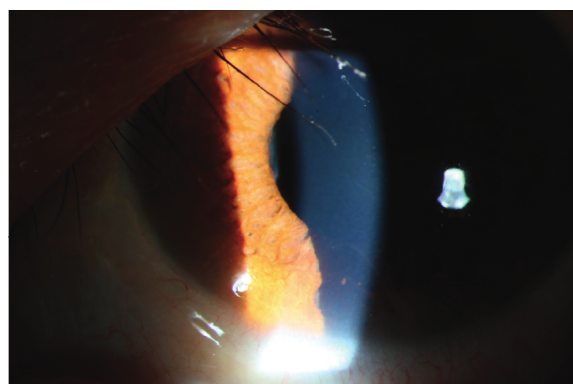
Figure 3: Pigmented KP under a slit lamp. Color photograph of the left eye of a 46-year-old female patient shows typical pigmented KP and moth-eaten iris depigmentation under a slit lamp. Two pig- mented KPs can be seen in the lower position. PSS � Posner–S- chlossman syndrome; KP � keratic